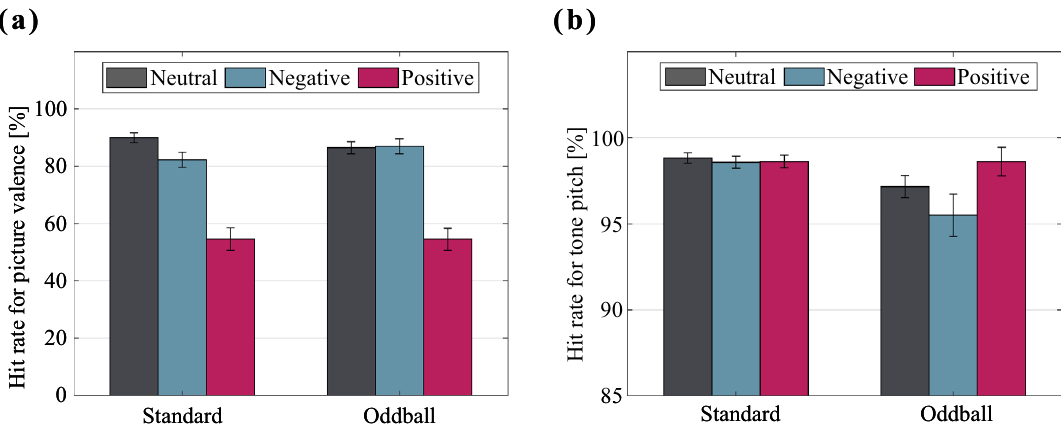
Figure 1. Behavioral results. ( a ) The hit rates for the picture valence. ( b ) The hit rates for the tone pitch. The error bars indicate the standard error of the